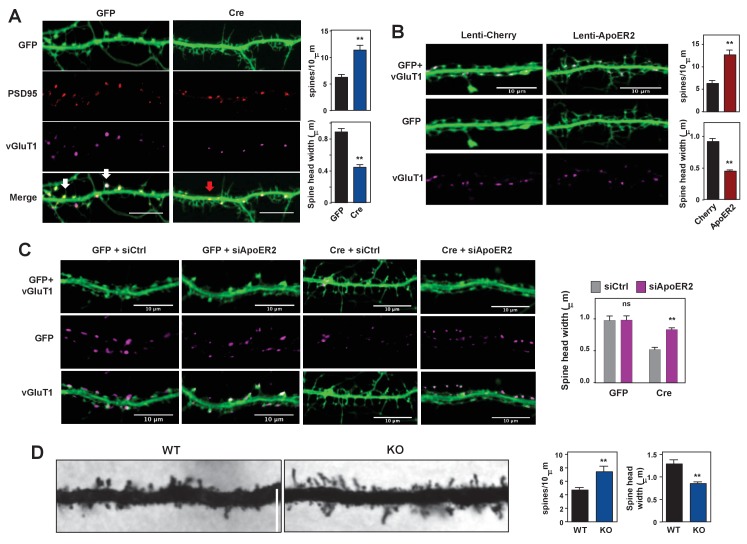
Loss of IDOL impairs dendritic Spine morphogenesis and maturation.(A) Representative images showing immunofluorescence staining of dendrites from Mylipflox/flox hippocampal neurons transduced with either AAV-CamKII-GFP or AAV-CamKII-CRE-GFP. Neurons were transduced at DIV 5, and fixed and stained at DIV 19–20. Spine synapse, white arrow; Shaft synapse, red arrow; Green, GFP; Red, PSD95; Magenta, vGluT1. Scale bars, 10 µm. Quantification of spine density and spine-head width of neurons (including filopodia-like protrusions) is shown on the right (n = 10–12/group). **p<0.01 by Student’s t test. (B) Representative images showing immunofluorescence staining of dendrites from WT hippocampal neurons transduced with either Lenti-Cherry or Lenti-ApoER2. Neurons were transduced at DIV 10, and fixed and stained at DIV 19–20. Both groups were also transduced with a AAV-CamKII-GFP DIV15 to allow visualization of spines. Green, GFP; magenta, vGluT1. Scale bars, 10 µm. Quantification of spine density and spine-head width of neurons from (including filopodia-like protrusions, n = 10–12/group) is shown on the right. **p<0.01 by Student’s t test. (C) Representative images showing immunofluorescence staining of dendrites from Mylipflox/flox hippocampal neurons transduced with either AAV-CamKII-GFP or AAV-CamKII-CRE-GFP at DIV10. Control siRNA (1 µM) or ApoER2 siRNA (1 µM) were then added to the culture medium at DIV16 and applied again after 48 hr. Neurons were fixed and stained at DIV21. Green, GFP; magenta, vGluT1. Scale bars, 10 µm. Quantification of spine-head width of neurons (including filopodia-like protrusions, n = 10–12/ group) is shown on the right. (D) Representative images of primary CA1 apical dendrites (about 150 µM from the soma) in Golgi-impregnated slices from 5-weeks-old WT and IDOL-deficient mice. Scale bars, 5 µm; quantification of dendritic spine density along the dendrites of Golgi-impregnated CA1 hippocampal neurons obtained from WT (n = 9 total neurons, 3 animals) and IDOL-deficient mice (n = 10 total neurons, 3 animals) is shown on the right. Error bars represent SEM. **p<0.01 by Student’s t test. Primary neuron images presented in this figure are from ≥2 independent experiments, 5–8 randomly selected neurons are imaged for each experiment and used for statistical analysis.